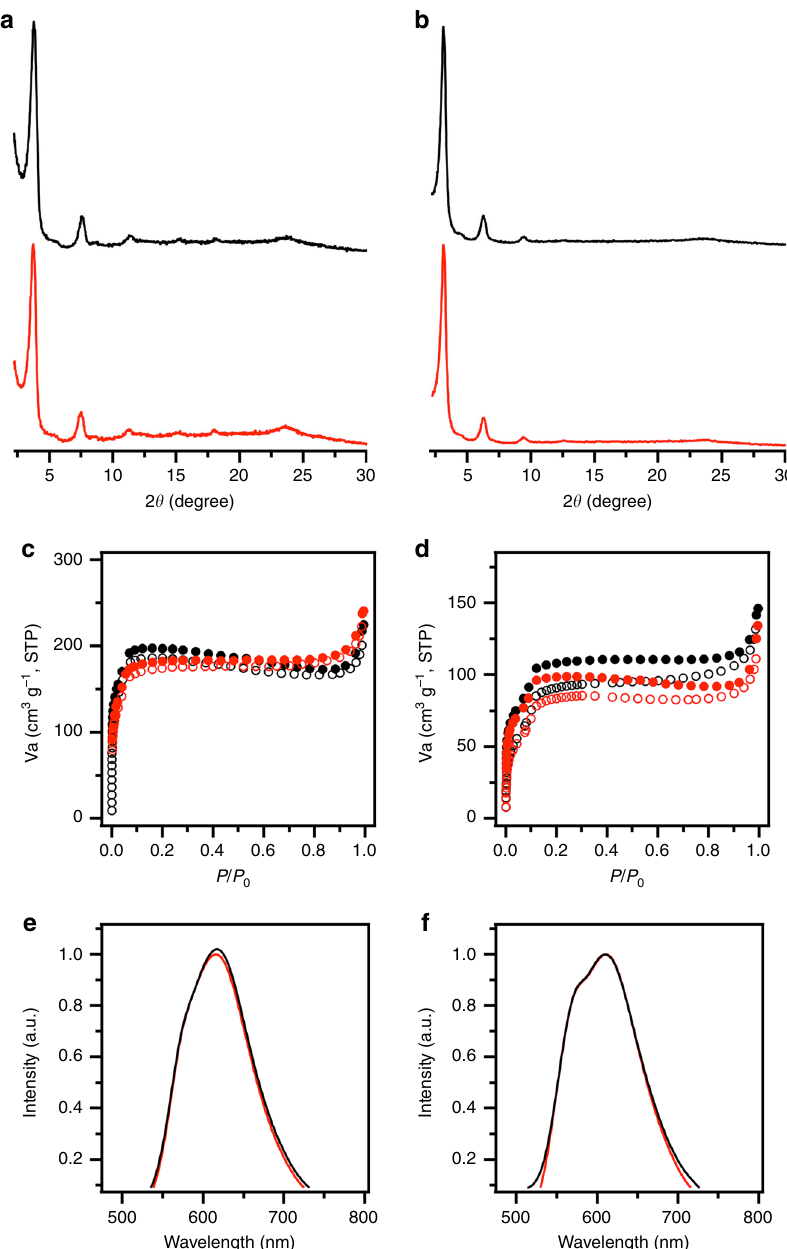
Fig. 3 Stability in air. a , b PXRD patterns of a sp 2 c-COF and b sp 2 c-COF-2 upon exposure to air over 1 year. c , d Nitrogen sorption isotherm curves of c sp 2 c-COF and d sp 2 c-COF-2 upon 1-year exposure to air. e , f Fluorescence spectra of e sp 2 c-COF and f sp 2 c-COF-2 upon exposure to air over 1 year. Black and red curves are samples before and after exposure to